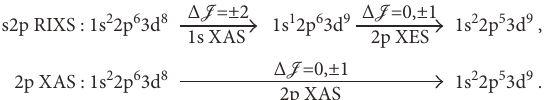
. Note that the fi nal state is similar to 3d